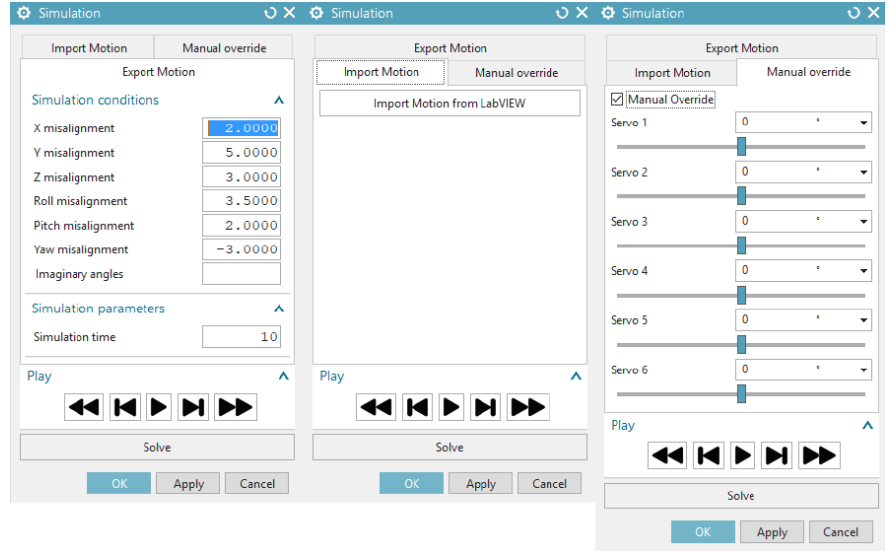
Figure 5. The NXOpen interface with all three tabs visible—here, the user can specify supervisory setpoint values to position the platform before